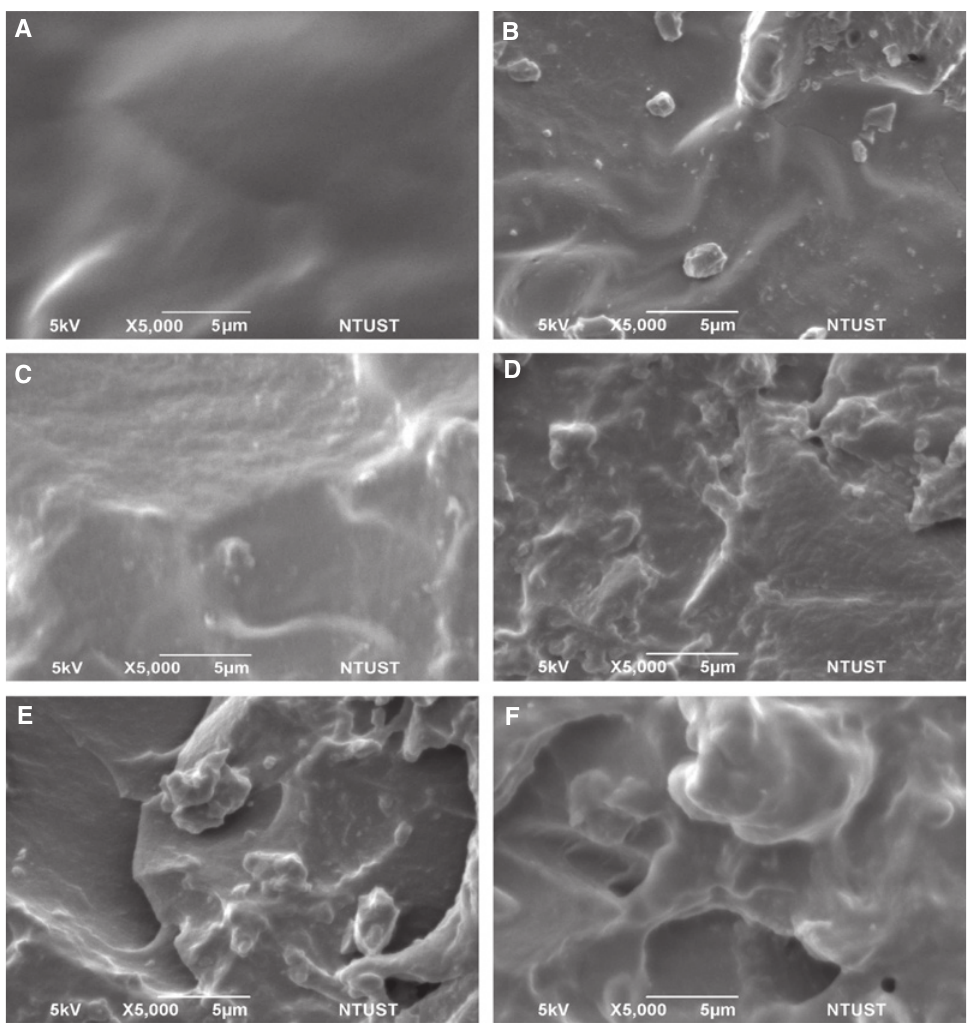
nanocomposite. (A) 0 phr, (B) 1 3